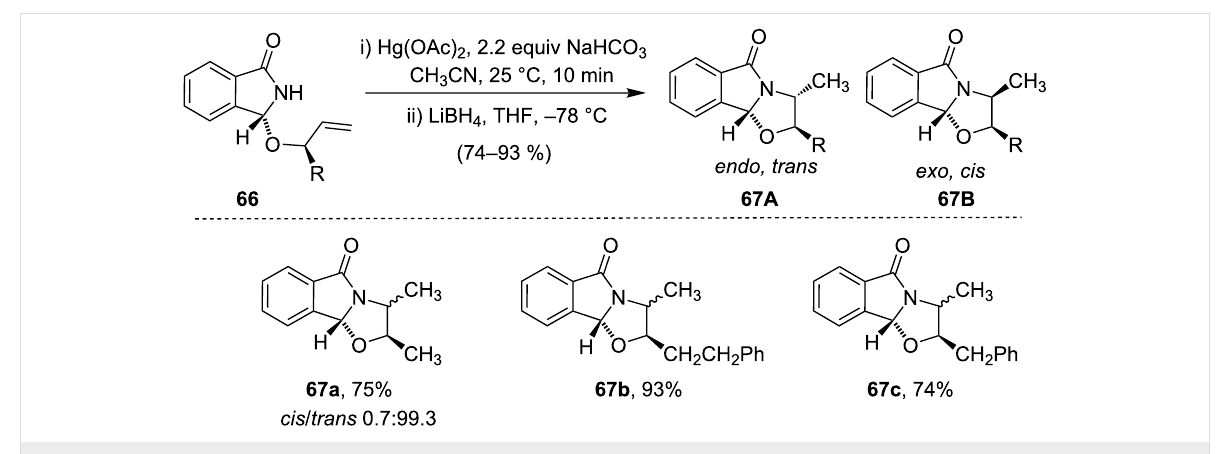
Scheme 23: Cyclization of amide derivatives induced by Hg(OAc) 2